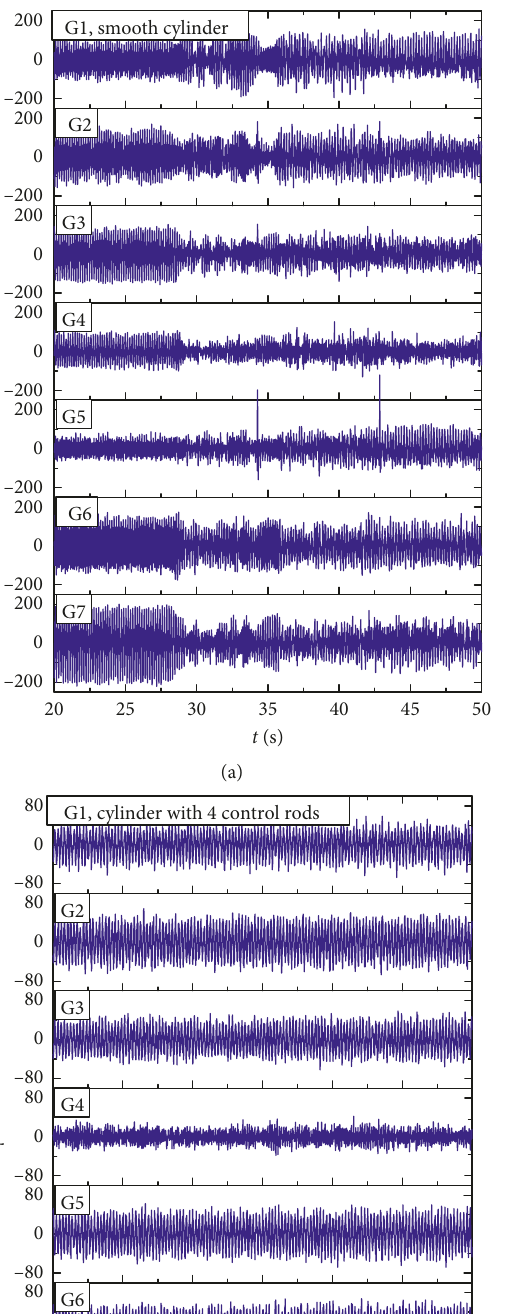
0 ° ) without and with control rods undergoing vortex shedding at (cid:31)